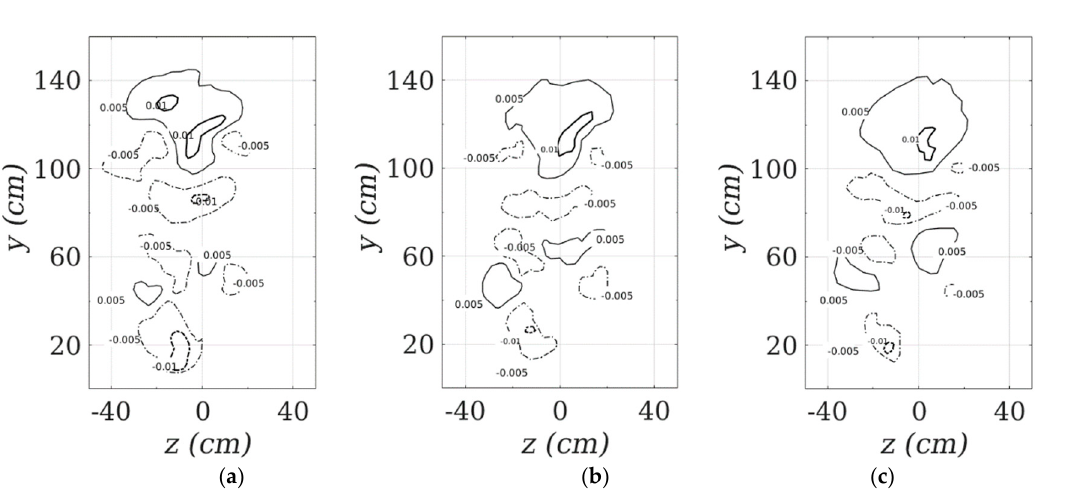
Figure 4. Contour of the pressure coefficient, C p = ( p-p ∞ )/0.5 ρ U ∞ 2 , at 0.8 m downstream of the rear wheel: ( a ) experimental measurements; ( b ) LES; ( c ) Tuned